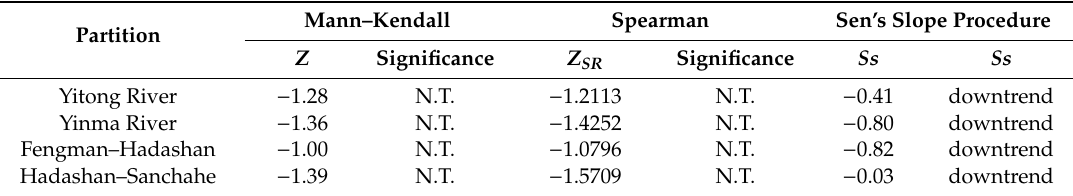
Table 1. Trend test results of annual runo ff in in SSRB.